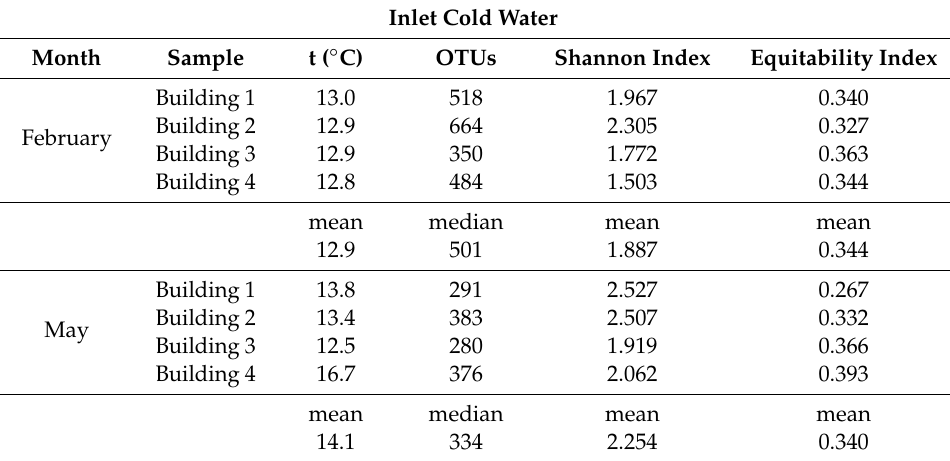
Table 1. Temperature (t), operational taxonomic units (OTUs), Shannon and equitability index for each cold water